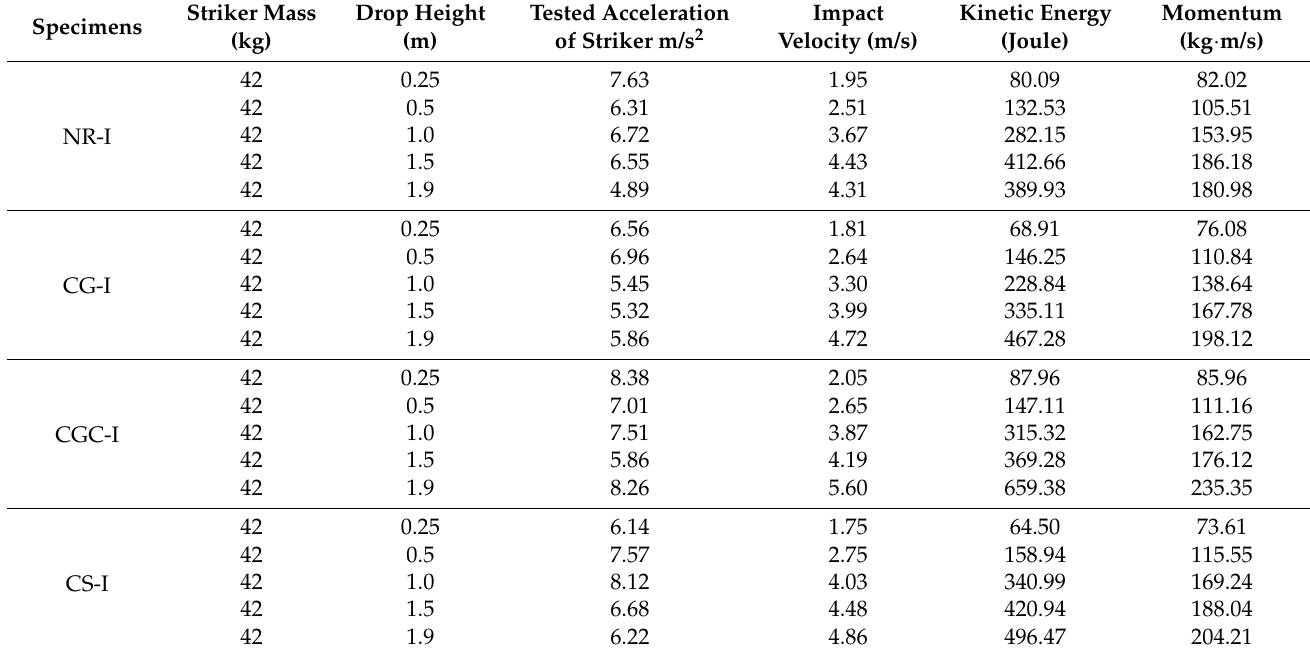
Table 4. Characteristics of the impact